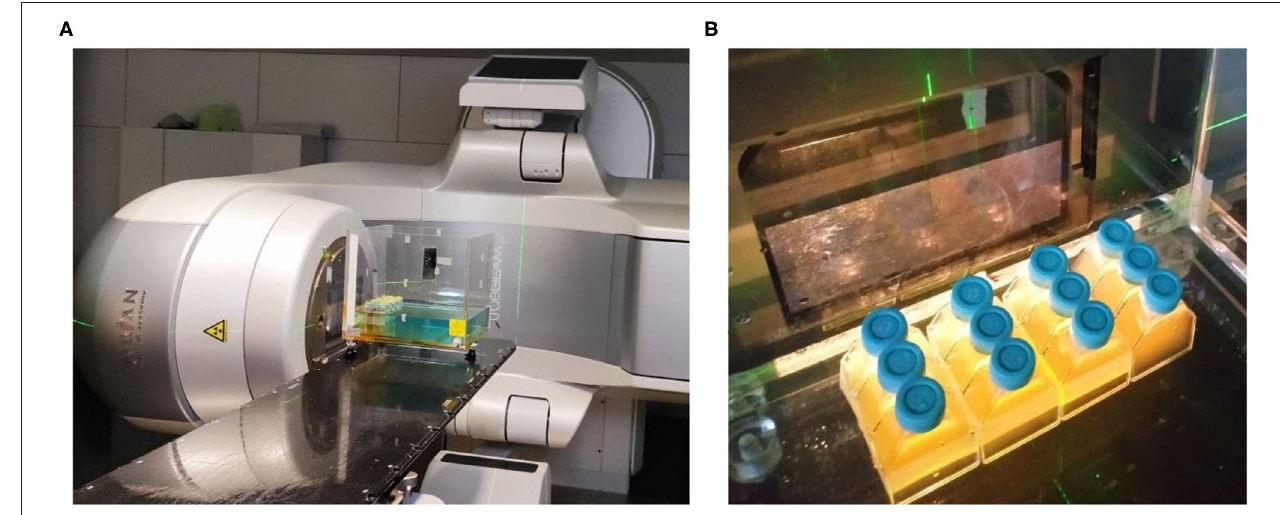
FIGURE 1 | First Ionizing Radiation exposure experiment setup, featuring the Varian True-Beam STX ® accelerator used (A) , and the positioning of the flasks inside the water model at a Source-Skin Distance of 65 cm (B)